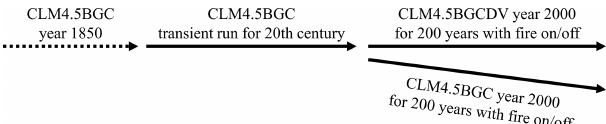
Figure 1. Flowchart showing model simulations conducted to in- vestigate the interactive impact of fires and ecological succession on the Earth system using Community Land Model (CLM4.5) sim- ulations extended with biogeochemistry (CLM4.5BGC) and BGC with dynamic vegetation